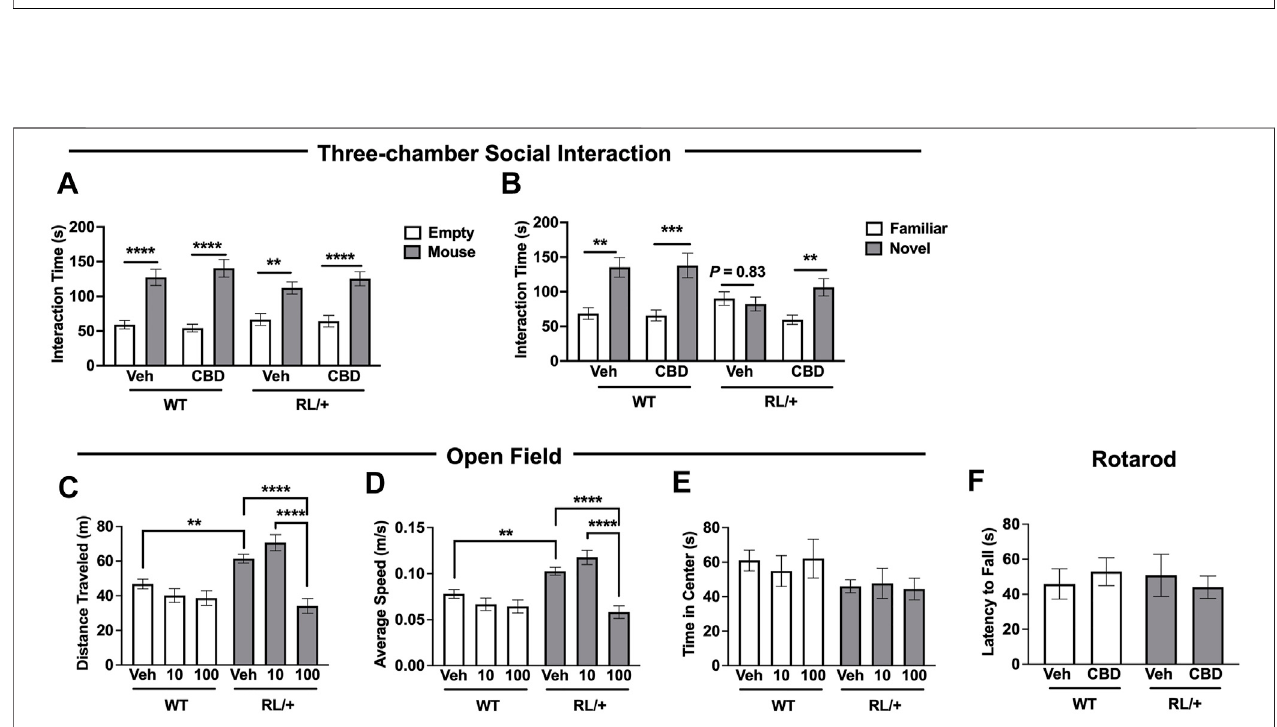
FIGURE 2 | Cannabidiol improves social behavior and reduces hyperactivity in RL/+ mutants. (A) RL/+ mutants and WT littermates displayed normal sociability following vehicle or CBD treatment. (B) Vehicle-treated RL/+ mutants exhibited de fi cits in social discrimination; however, CBD (10 mg/kg) was able to restore more normal social discrimination in the mutants. (A,B) N (cid:1) 12-13/group. (C,D) Following the administration of CBD (100 mg/kg), distance traveled by the RL/+ mutants (C) and their average speed (D) werecomparable to WT littermates. CBD (10 mg/kg) had no effecton locomotor activity regardless ofgenotype. (E) The time spent in the center of the apparatus was comparable across both genotypes and treatment groups. (C – E) N (cid:1) 12 – 26/group. (F) CBD (100 mg/kg) does not impair motor coordination in RL/+ mutants and WT littermates. N (cid:1) 8 – 9/group. ** p ≤ 0.01, *** p ≤ 0.001, **** p ≤ 0.0001.